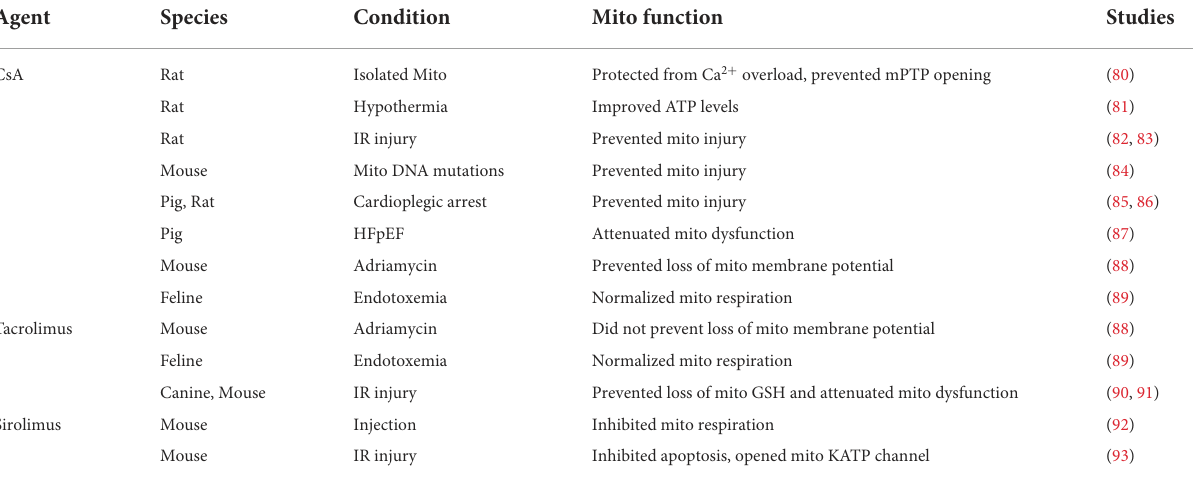
TABLE 2 Studies examining effects of immunosuppression on cardiac mitochondrial function.